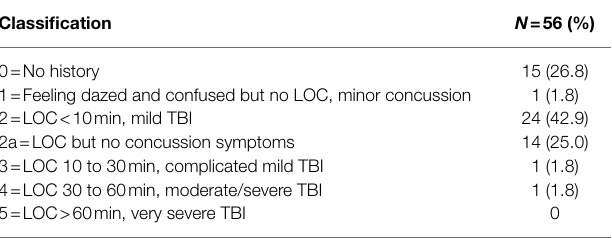
TABLE 2 | Traumatic Brain Injury Assessment (Williams et al., 2010).